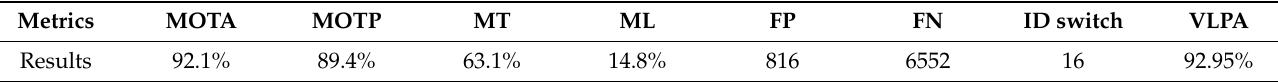
Table 5. The tracking results of the proposed algorithm.